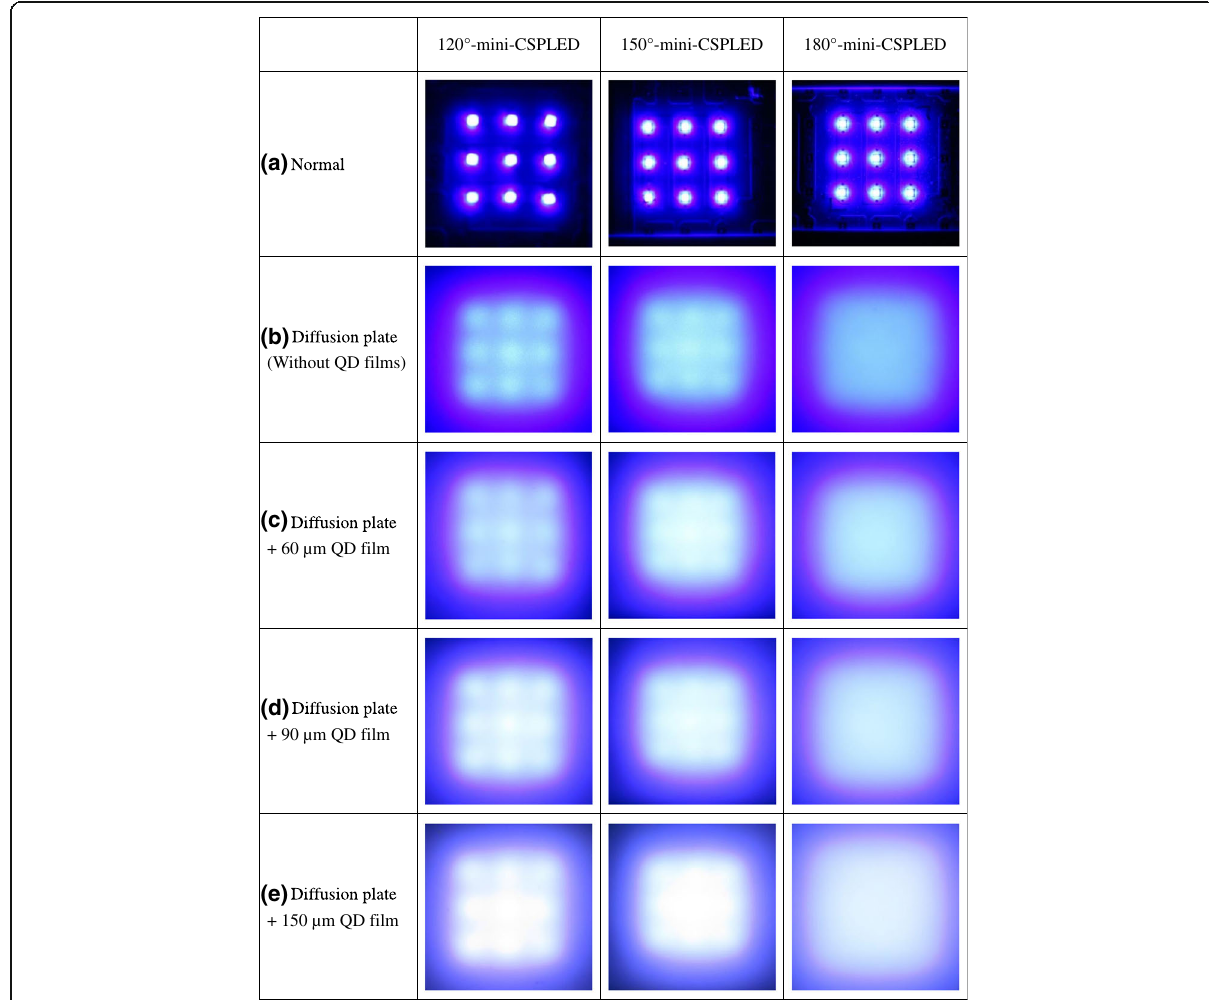
Fig. 7 Light distribution images of 120° mini-CSPLED BLU, 150° mini-CSPLED BLU, and 180° mini-CSPLED BLU with and without a diffusion plate and different QD film